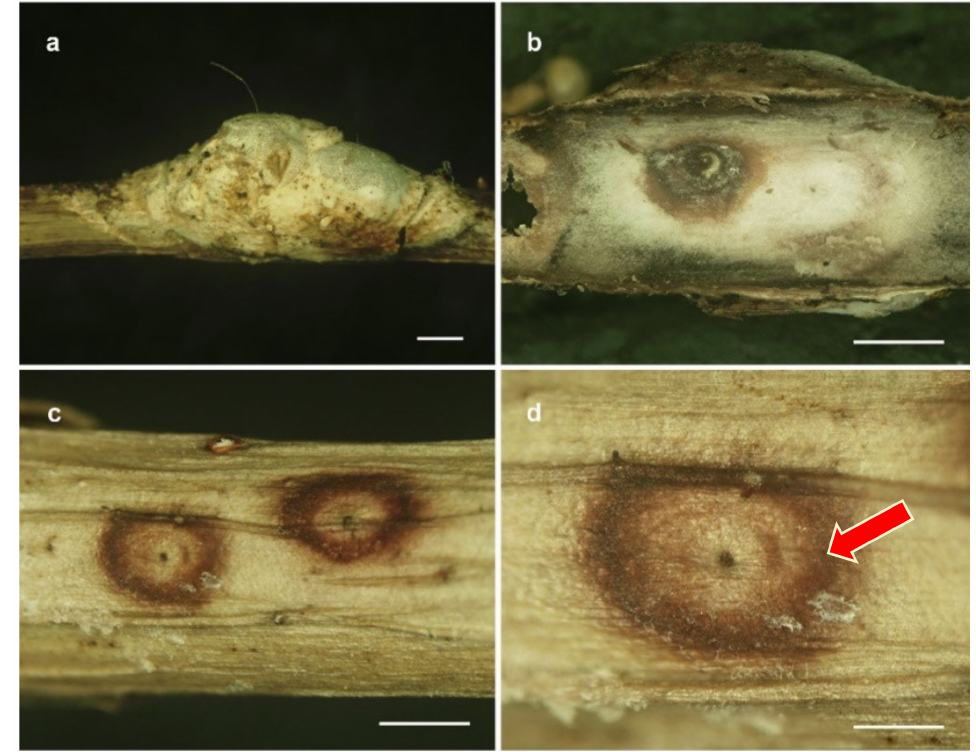
Figure 7. Photographs showing the interaction between fungus, plant and scale insect. ( a ) Fungal stroma on the stem of a dicotyledonous plant. ( b ) Underside of fungal stroma removed from the stem. ( c , d ) Underside of fungal stromata with ventage (arrow) from which the scale insect stylet entered the plant host. Scale bars = ( a , b , c ) = 1 mm; ( d ) = 0.05